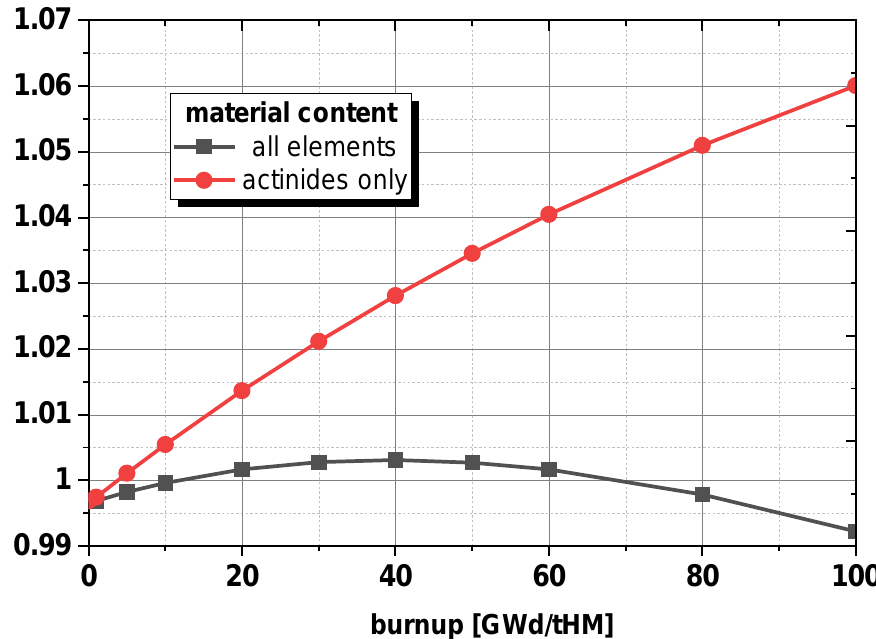
Figure 4. Criticality over burnup for the base case (213 cm from Figure 2) for the investigation compared to criticality development for a virtual system without fission products.